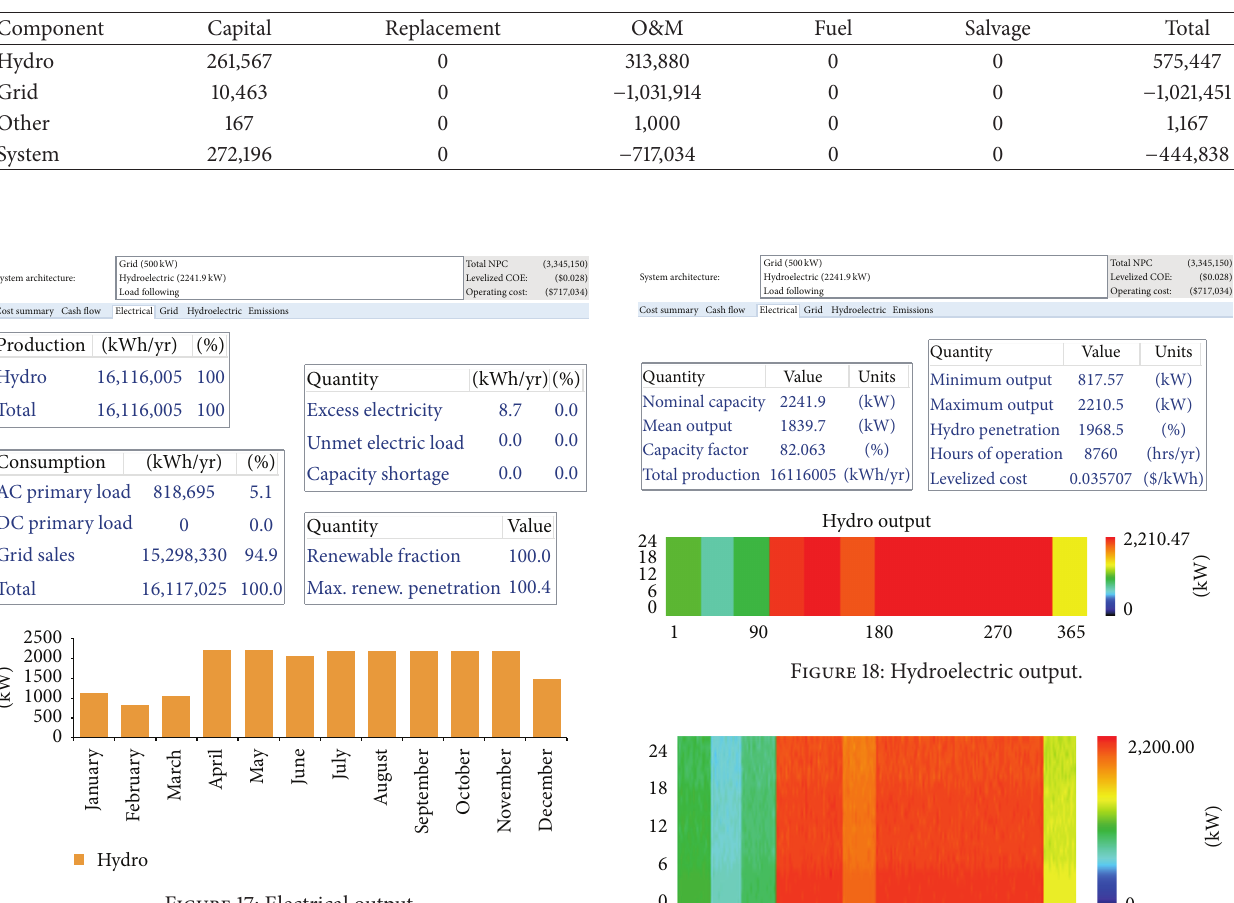
Table 8: Annualized costs.